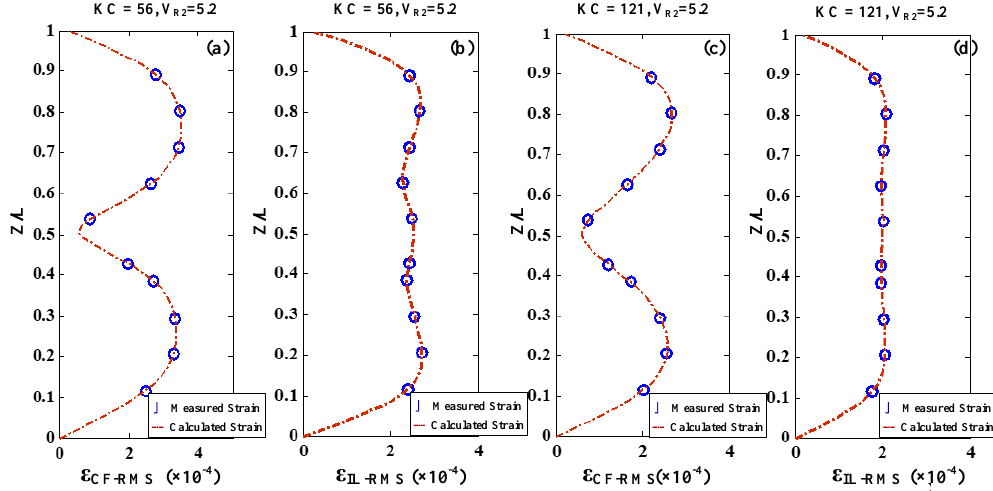
Figure 7. Distributions of the measured and calculated strains in the CF and IL directions for different KC numbers.